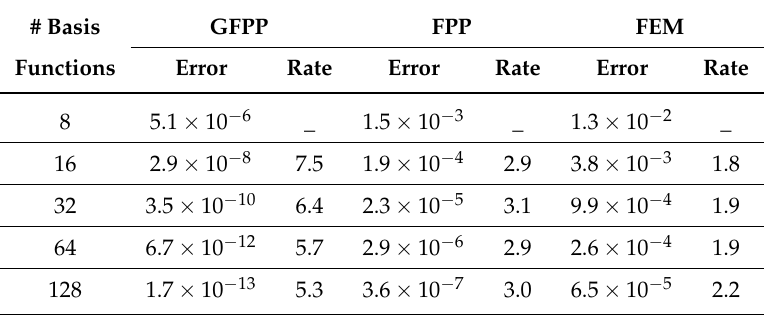
Table 1. The error estimation and convergence rate of numerical solutions to the analytic solution in Example 2.